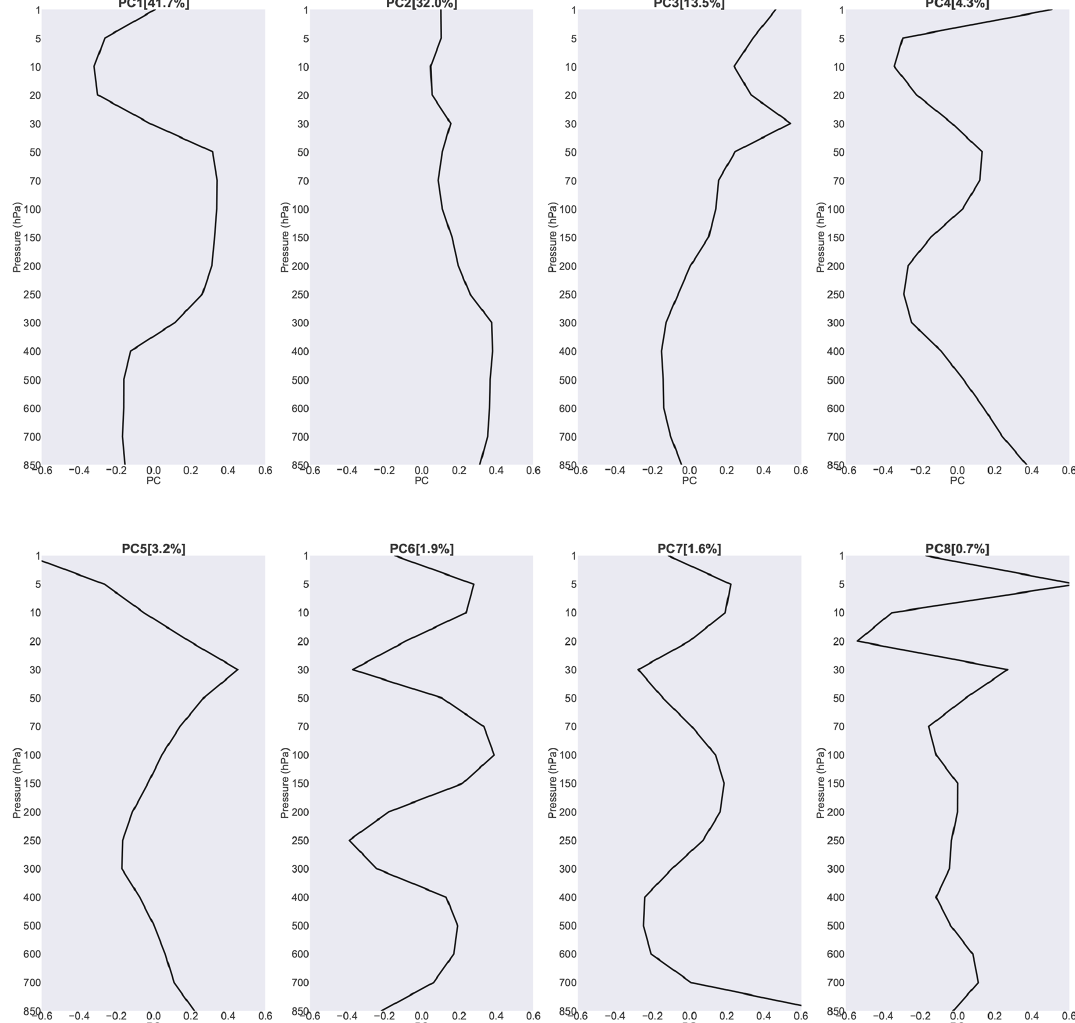
Figure A1. Principal components (PCs) showing the percent variance statistically explained by each PC (in parentheses).